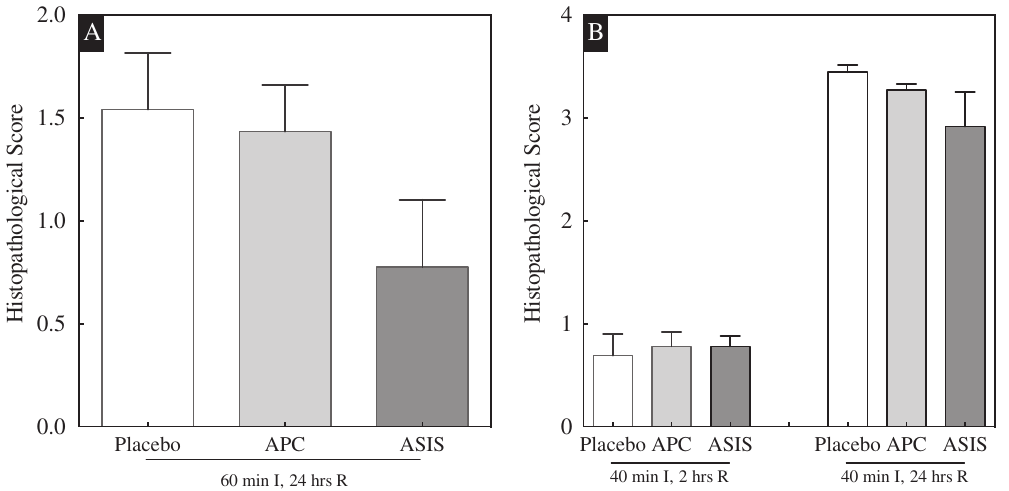
Figure 2. Panel A: histopathological scoring did not reveal an in fl uence of APC on renal injury after 1 hr of I followed by 2 hr of R but revealed a trend toward a decreased score upon ASIS administration compared to placebo. Panel B: APC nor ASIS administration in fl u- enced the histopathological score after 40 min of I followed by 2 or 24 hr of R. Values are mean ± SEM, n = 10, * p < 0.05.